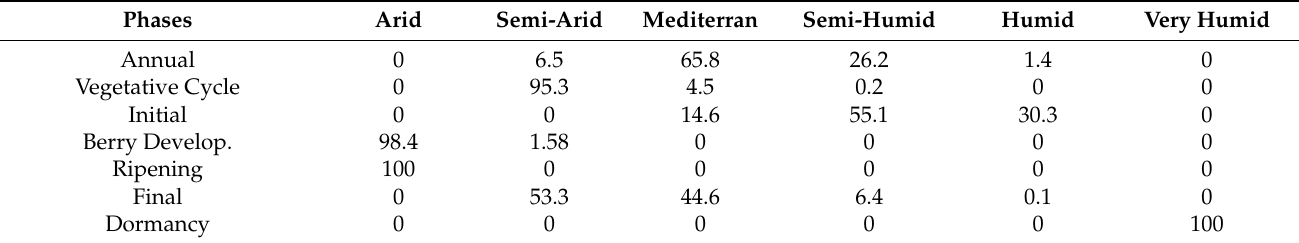
Table 4. Spatial classification (%) of the Ribera del Guadiana Protected Denomination of Origin, according to the IDM for the vine phases (1989–2020).